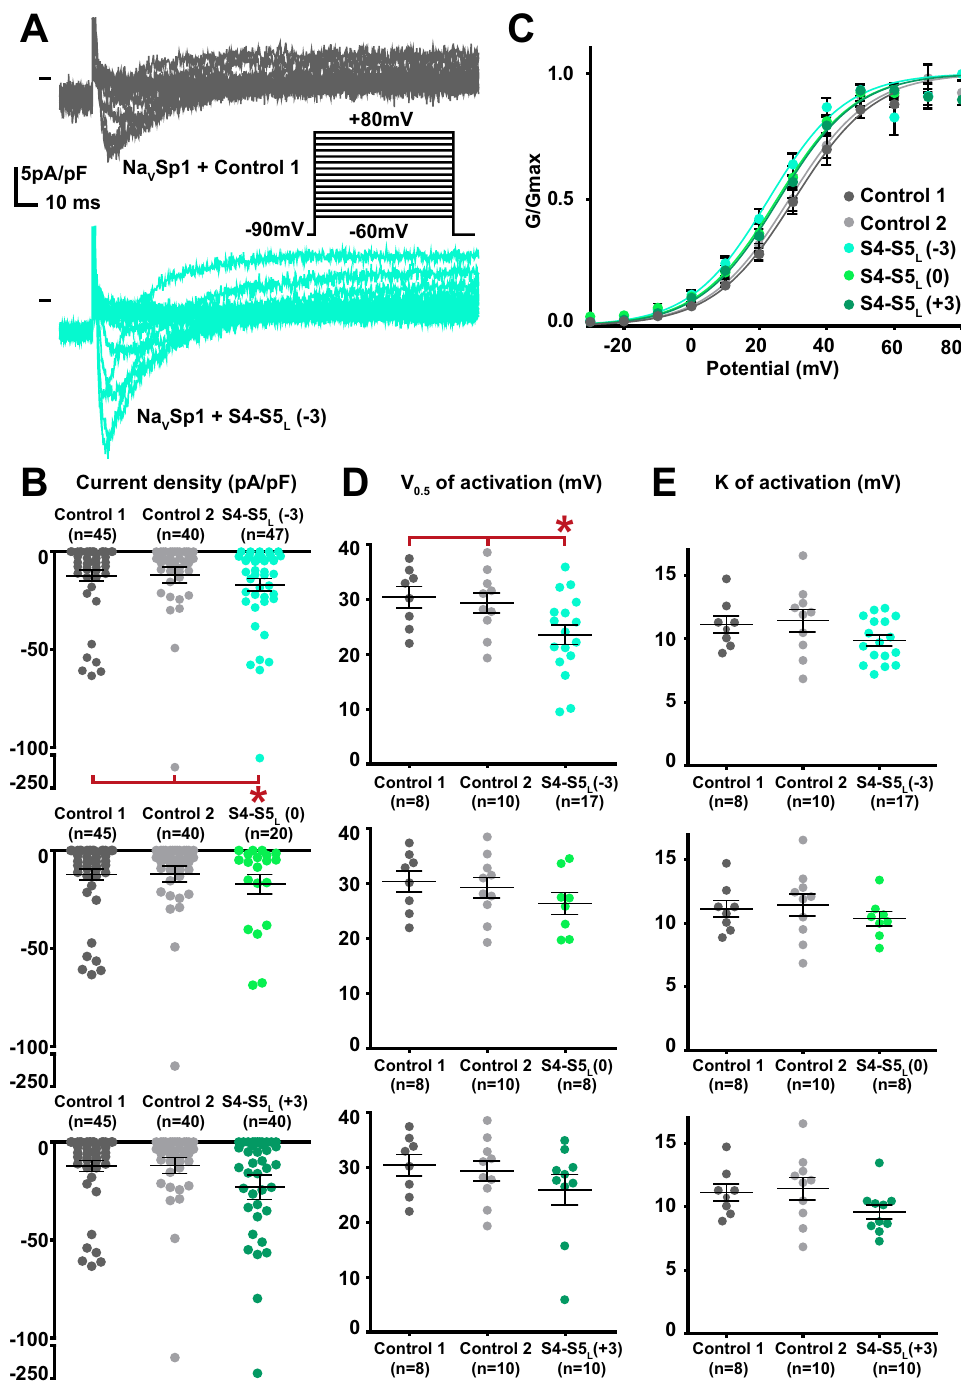
Figure 2. Effect of Na V Sp1 S4-S5 L mimicking peptides on Na V Sp1 current density and activation curve. ( A ) representative, superimposed current recordings in COS-7 cells transfected with Na V Sp1 and control 1 (top trace) or S4-S5 L ( − 3) peptide (bottom trace). Inset: activation voltage protocol used (holding potential: − 90 mV; 300-ms pulse at the indicated potentials; one sweep every 5 s). ( B) Dot plot and mean ± sem of peak Na V Sp1 current densities recorded in COS-7 cells co-transfected with Na V Sp1 and the indicated peptide, at 30 mV. ( C) Relative peak conductance versus membrane potential curves for Na V Sp1 channels in COS-7 cells co-transfected with Na V Sp1 and the indicated peptide. Lines are Boltzmann fits to the data. ( D,E) Dot plot and mean ± sem of Na V Sp1 half-activation potential (V 0.5 ; D ) and activation slope (K; E ) in COS-7 cells co-transfected with Na V Sp1 and the indicated peptide. * p value vs . both controls <